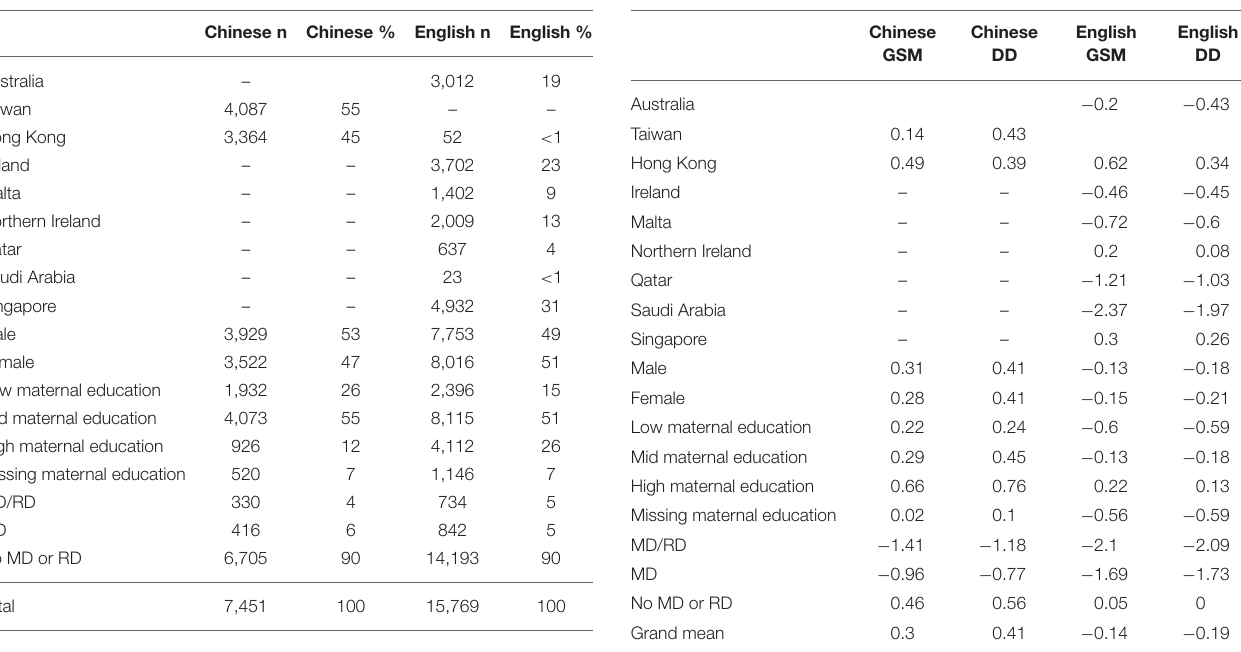
TABLE 1 | Participants by Language. TABLE 2 | Mean scores on geometric shapes and data display by